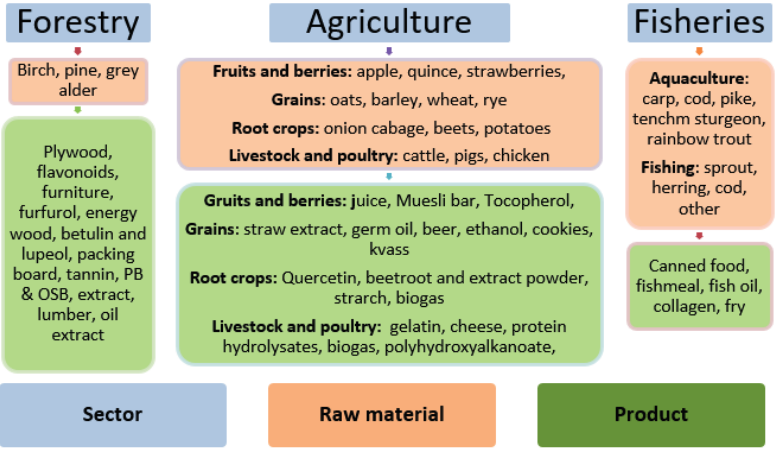
Fig. 2. Bioeconomy sectors, raw materials and products at SD